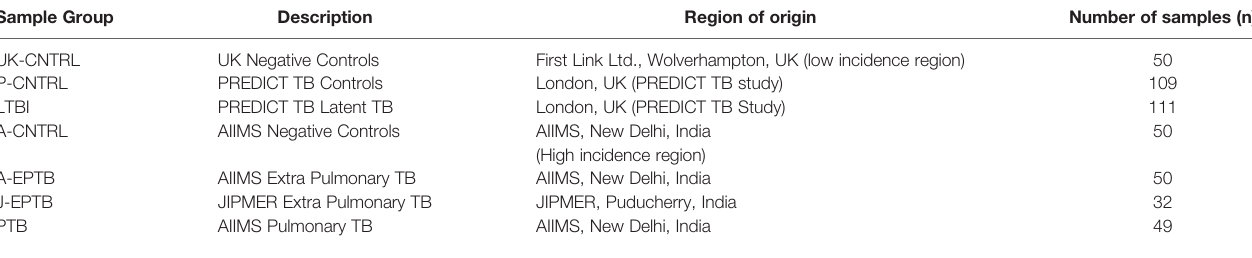
TABLE 1 | Summary of the number of patients per group for all patient and control samples and af fi liations with collaborating site in the study. Sample Group